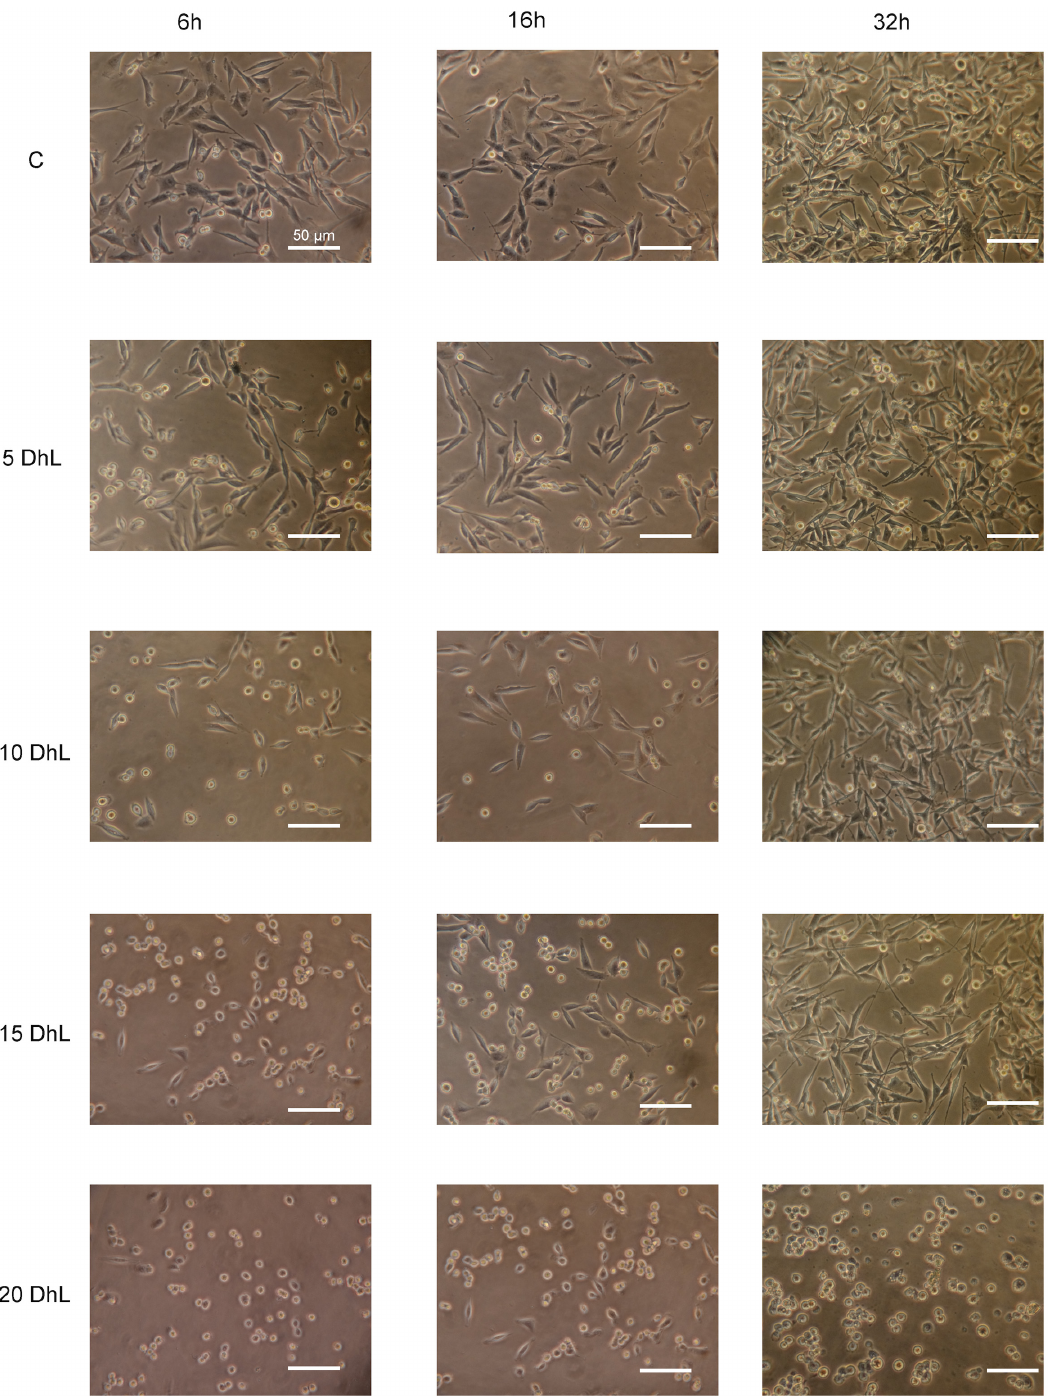
Fig 2. DhL modulated morphological changes in D384 cells. D384 cells were treated with 0, 5, 10, 15 and 20 μ M DhL for 6 h, 16 h and 32 h, visualized under microscope and imaged. Magnification: 40X.